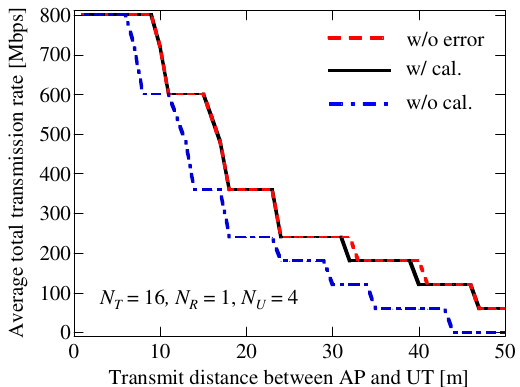
Figure 13. Transmission rate (TR) vs. distance between base station (BS) and user terminal (UT), with and without calibration and for ideal case without error.